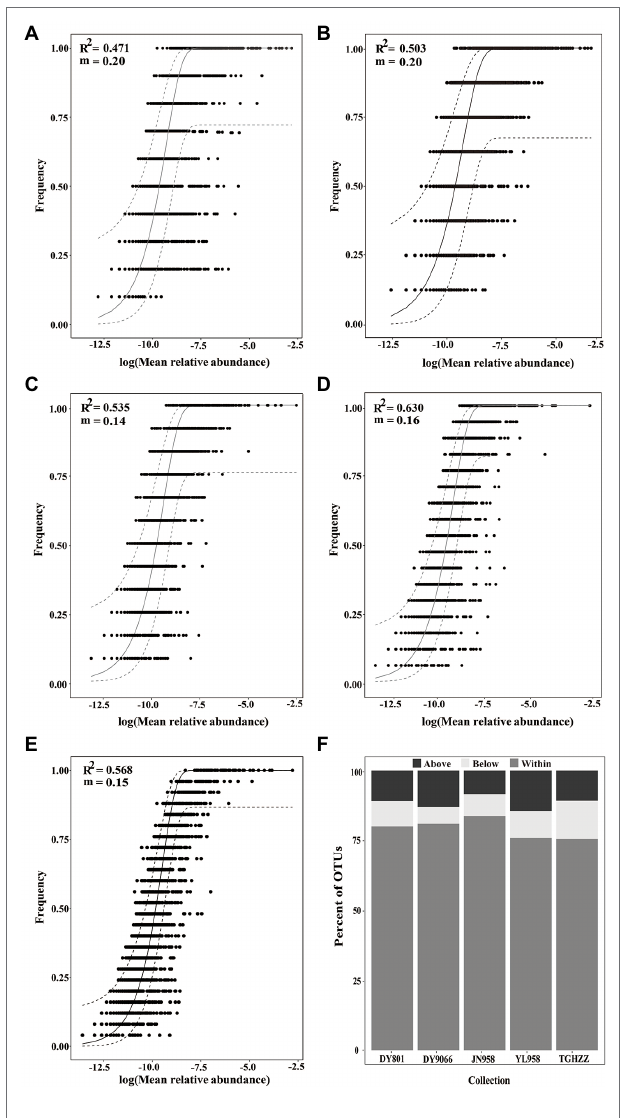
FIGURE 4 | Fit of neutral model for gut-associated bacteria of the Helicoverpa armigera caterpillars from 5 wild populations, (A) DY801, (B) DY9066, (C) JN958, (D) YL958, (E) TGHZZ, and (F) the percent of OTUs from each population that fell within, below and above neutral model prediction. An OTU was removed from the analysis if the relative abundance of that OTU in any sample was less than 0.5%. Each point in (A–E) represented an OTU in the gut. The solid gray lines represented the best fit to the model and dashed grey lines indicated the 95% confidence interval around the model